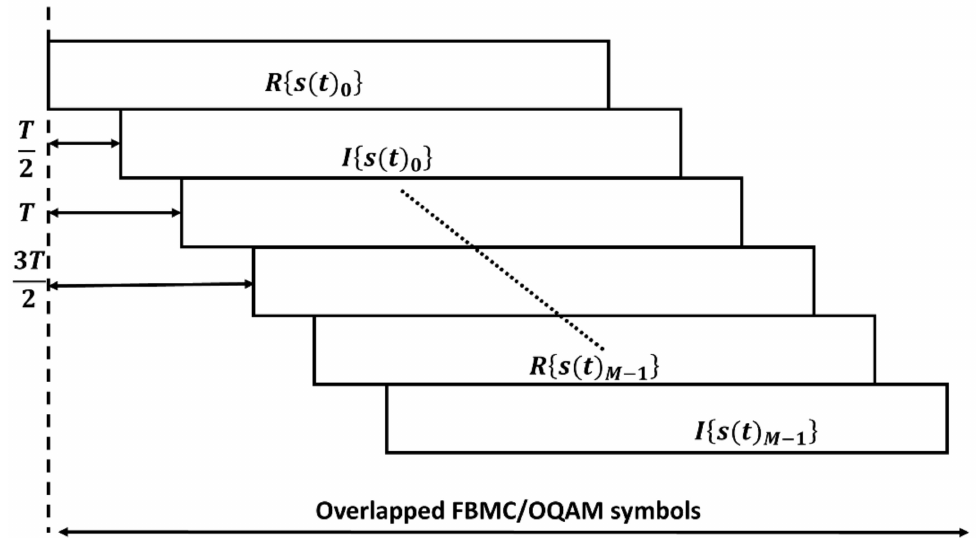
Figure 2. Structure of FBMC/OQAM (filter bank multicarrier with offset quadrature amplitude modulation)